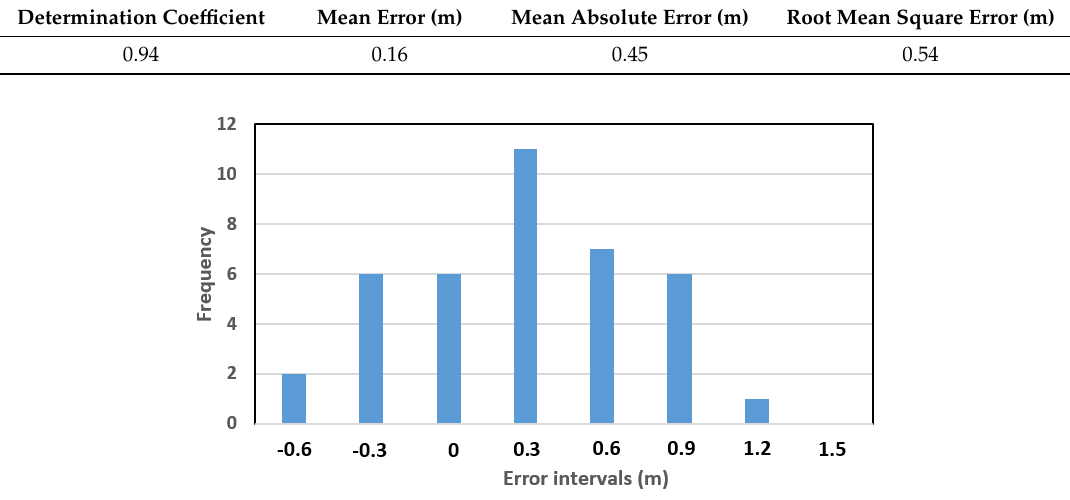
Figure A2. distribution of the errors.